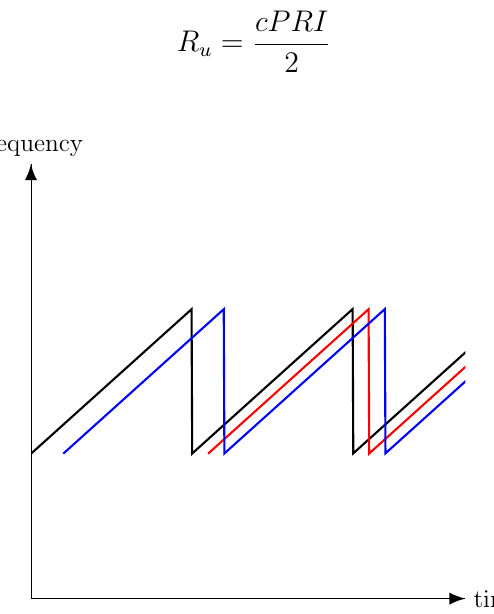
Figure 4. FMCW ambiguity in range: The first sweep reflection from the furthest target (red line) is between the transmitted signal (black line) and the second sweep reflection from the closest target (blue line), so that the furthest target is imaged